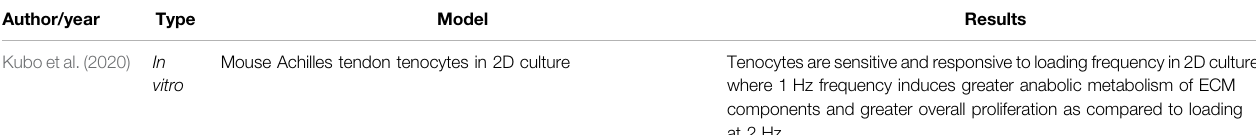
Mouse Achilles tendon tenocytes in 2D